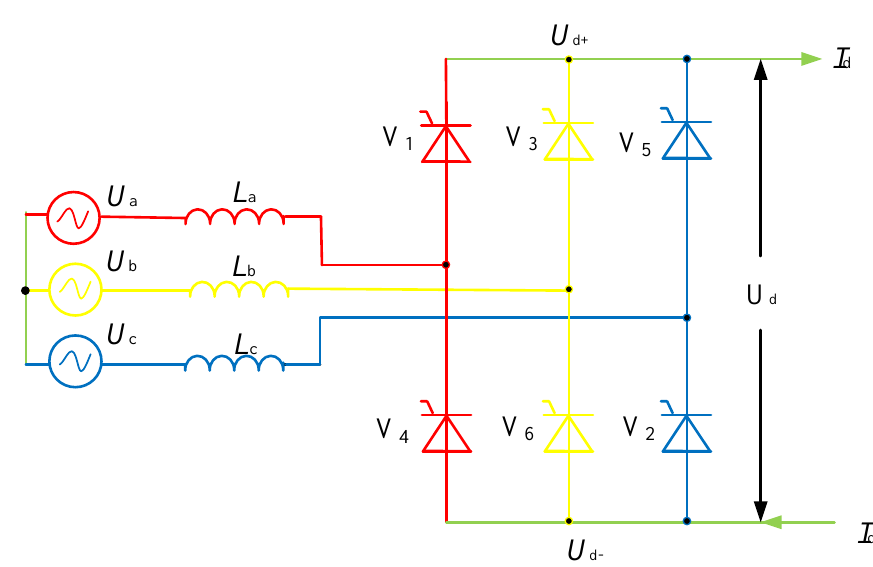
Figure 1. The structure of voltage source converters (VSC).